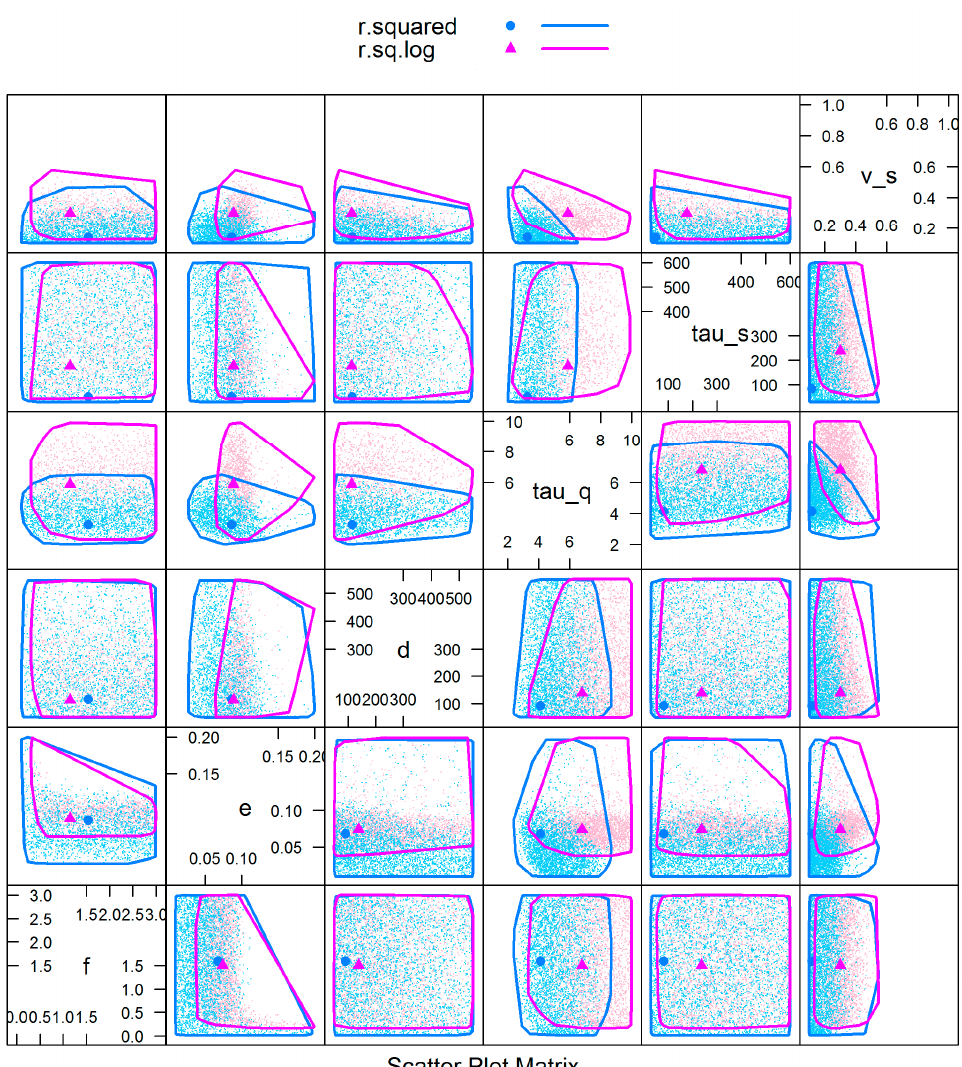
Figure 6. Two-dimensional projections of pairwise correlation of behavioral parameters for the IHACRES model using the CMADS (above diagonal) and TMPA-3B42V7 (below diagonal) precipitation datasets. The heavy dots represent the location of the best objective function value obtained from the GLUE sample.